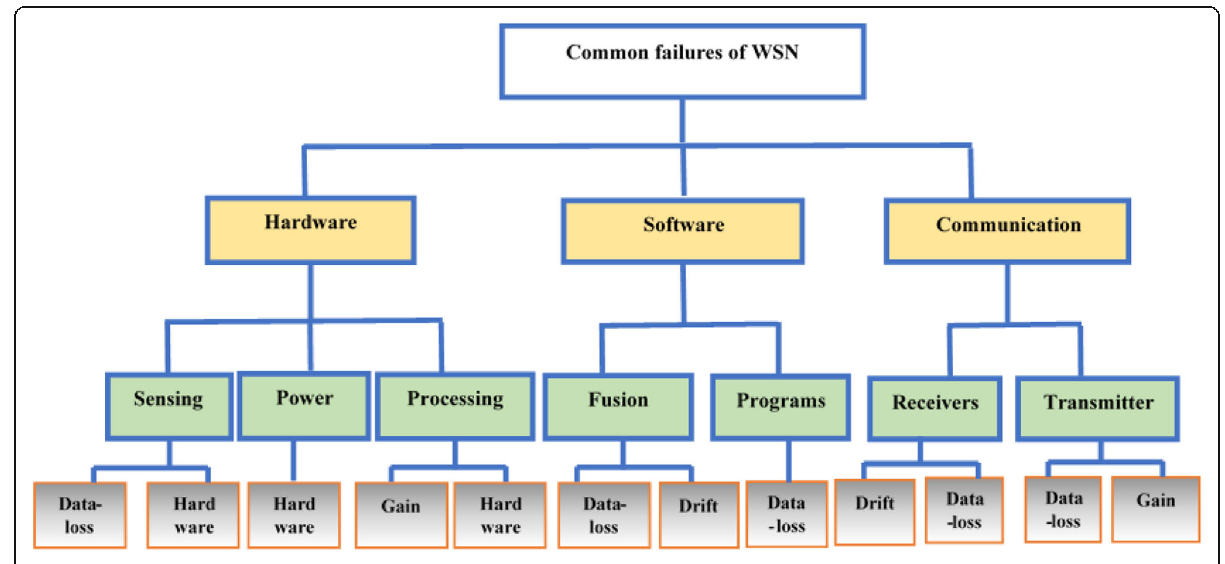
Fig. 2 The common faults occur in wireless sensor